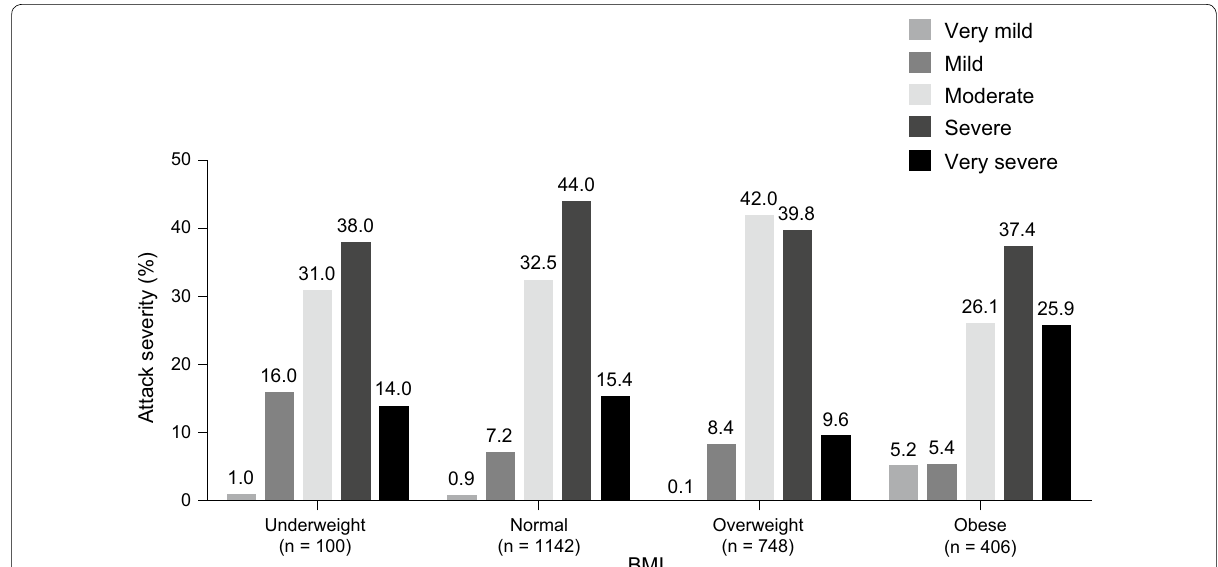
Fig. 1 Severity of icatibant-treated attacks by body mass index (BMI). P values comparing severity of attacks (very mild/mild/moderate versus severe/very severe): P 0.136 for normal versus overweight; P 0.627 for normal versus obese; P 0.109 for overweight versus obese. Results = = = excluding data from the two reinjection outliers are presented in Additional file 1: Figure S1. n number of attacks. Very mild very mild inter- = = ference with daily activities; mild mild interference with daily activities; moderate moderate interference with daily activities and no other = = countermeasures required; severe severe interference with daily activities and with or without other countermeasures; very severe very severe = = interference with daily activities and other countermeasures required